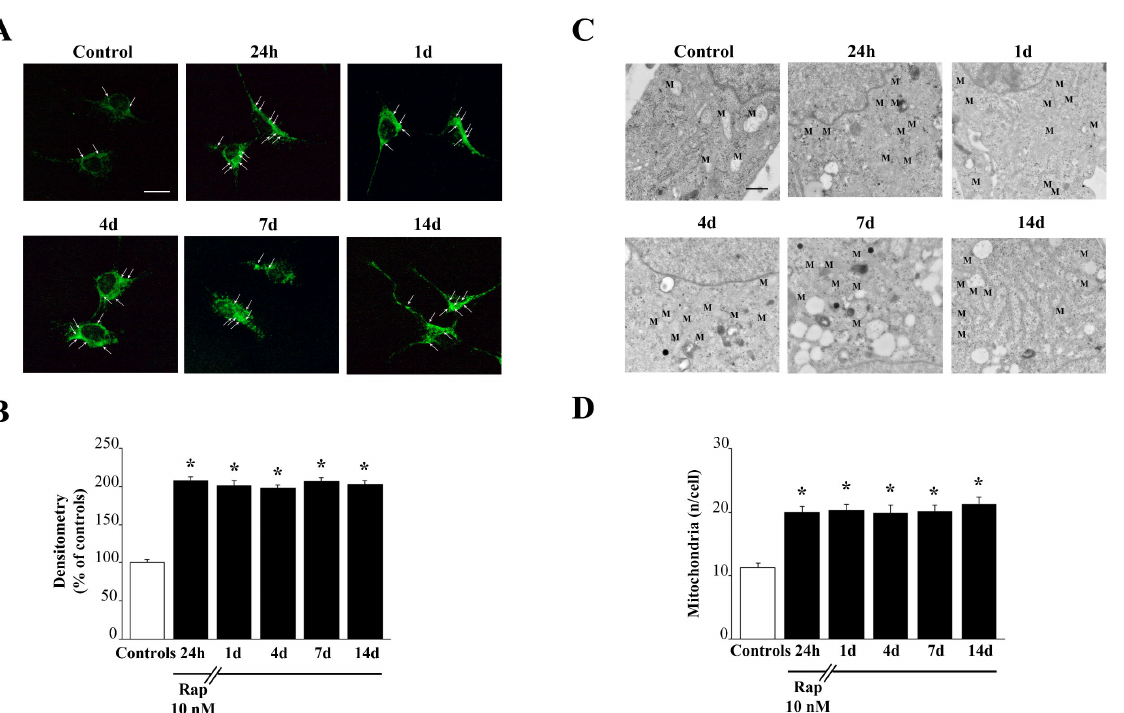
Figure 6. Rapamycin persistently increases the number of mitochondria and produces a long ‐ last ‐ ing rescue of altered mitochondria. ( A ) Representative pictures show total mitochondria stained with MTR ‐ G from controls and following rapamycin treatment (10 nM) for 24 h and after rapamy ‐ cin withdrawal (up to 14 d), Arrows indicate intensely fluorescent signals. ( B ) Graph reports the two ‐ fold steady increase in mitochondrial MTR ‐ G fluorescence induced by rapamycin, which per ‐ sists unmodified for 14 days. Values are given as the mean±S.E.M from N = 100 cells per group. ( C ) Representative pictures at TEM show the increase in mitochondria (M) counted directly as specific organelles. ( D ) Graph reports the count of mitochondria per cell at TEM which overlaps the two ‐ fold increase measured at MTR ‐ G fluorescence, which similarly persists at 14 days. Values are given as the mean±S.E.M from N = 50 cells per group. ( E ) Representative pictures depicting mitochondrial morphology evaluated based on the modified scale from Flameng et al. 1980 [23]. A score of 1 indicates that mitochondria possess broken crests (arrowheads) with ruptured